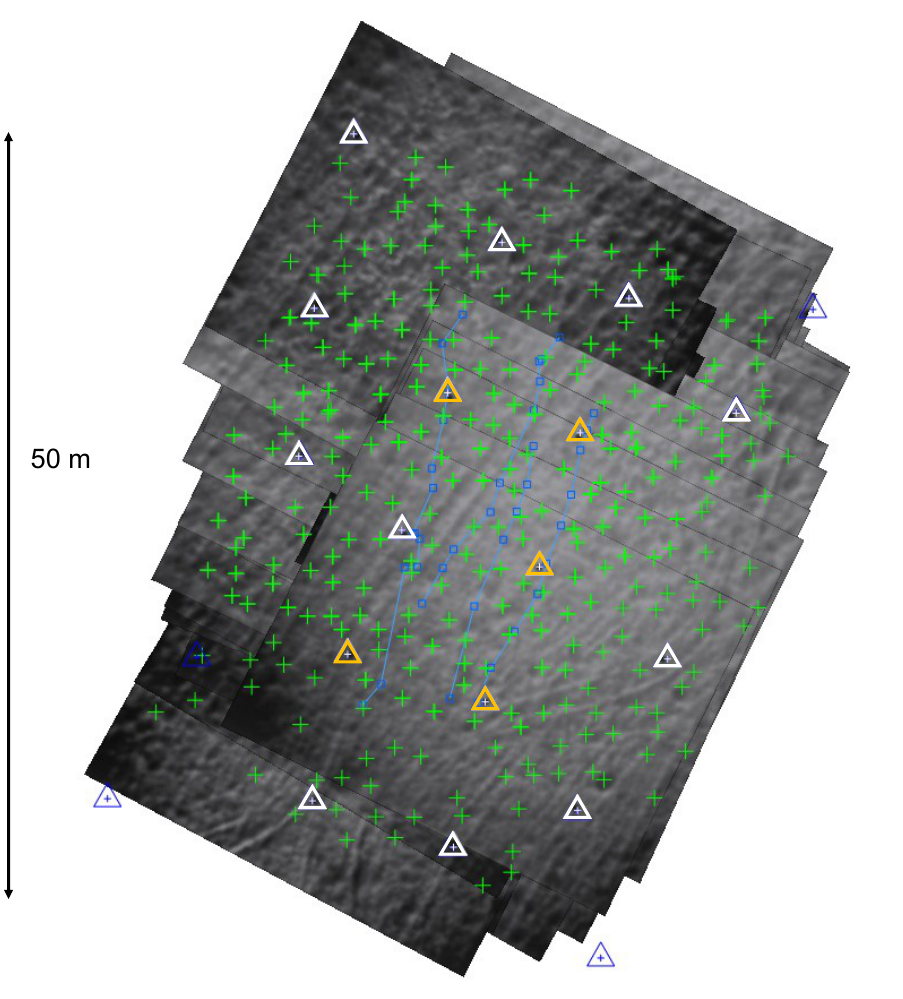
Figure 9: Visualization of the bundle block with tie points (plus signs), GCP locations (triangles) and flight strips (blue lines). With only 11 GCPs the bundle adjustment yields almost the same RMSE as with all 16. The differences in X , Y and Z are in the order of 1 cm . The height of the control points has a lot lower accuracy than the planimetry, possibly due to the flat topography, although the statistics based on 5 control points is rather